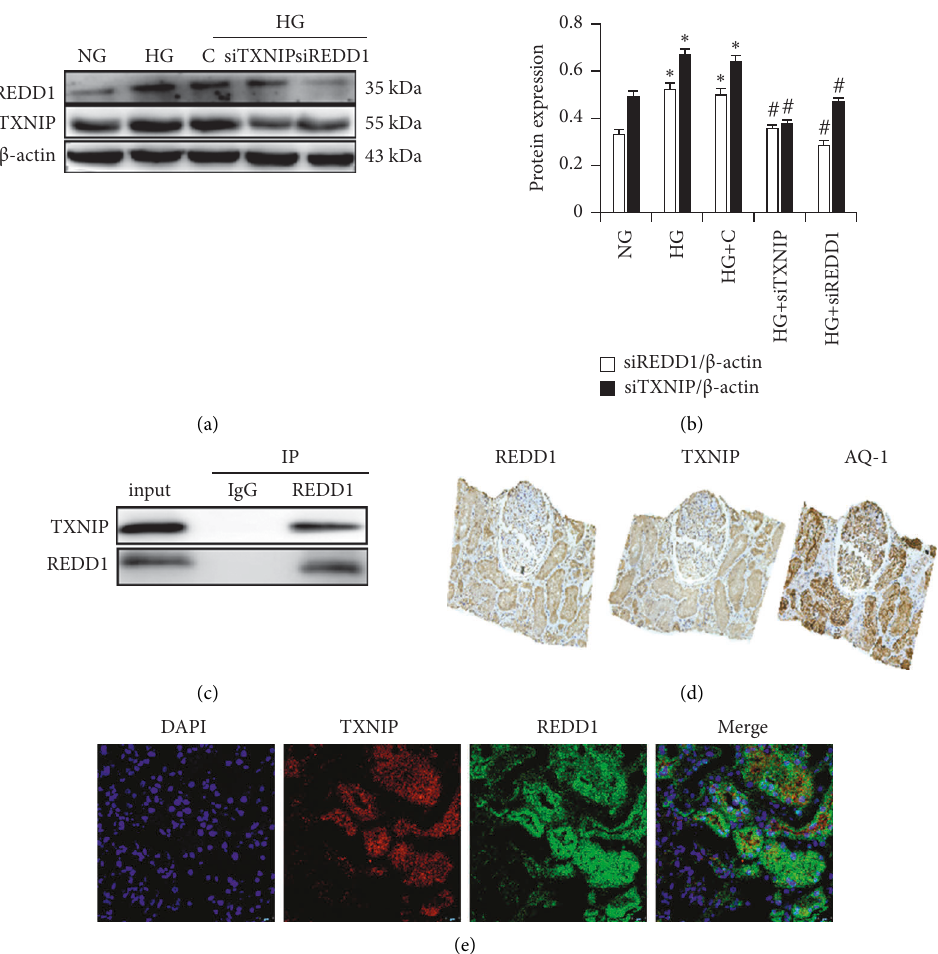
Figure 8: The relationship between REDD1 and TXNIP. (a, b) The expression of REDD1, TXNIP, and β -actin was analyzed by Western blot in HK-2 cells. (c) HG-induced endogenous REDD1/TXNIP complex was detected by Co-IP. (d) Immunohistochemical staining analysis of the expression of REDD1, TXNIP, and AQ-1 in diabetic nephropathy biopsies. (e) Double immunofluorescence labeling method analysis of the expression of REDD1 and TXNIP in the kidneys of diabetic nephropathy biopsies. Values are expressed as means NG: 5.6mM D-glucose; HG: 30mM D-glucose; HG +(C) 30mM D-glucose plus scramble. HG+ siREDD1: 30mM D-glucose +REDD1 siRNA. HG +siTXNIP: 30 mM D-glucose +TXNIP